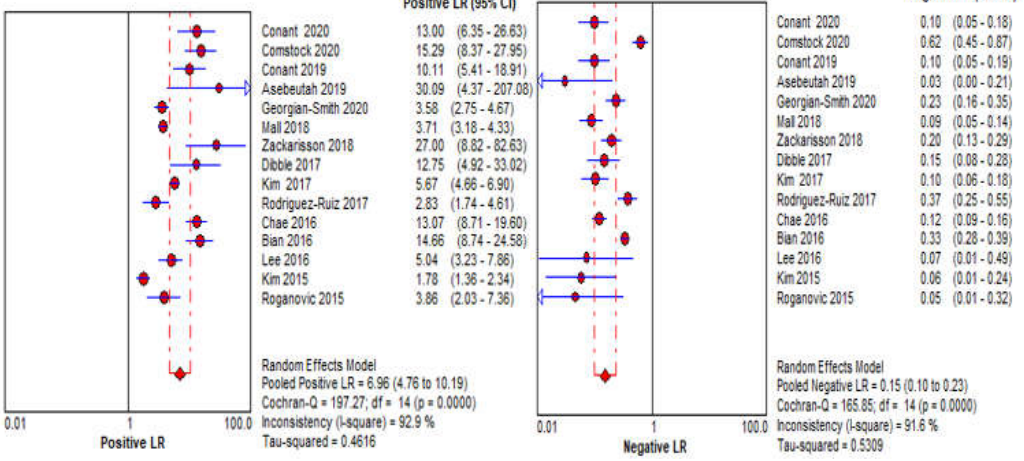
Figure 6. Forest plots of summary of positive ( LR + ) and negative ( LR − ) likelihood ratios of DBT using random effects bivariate model.